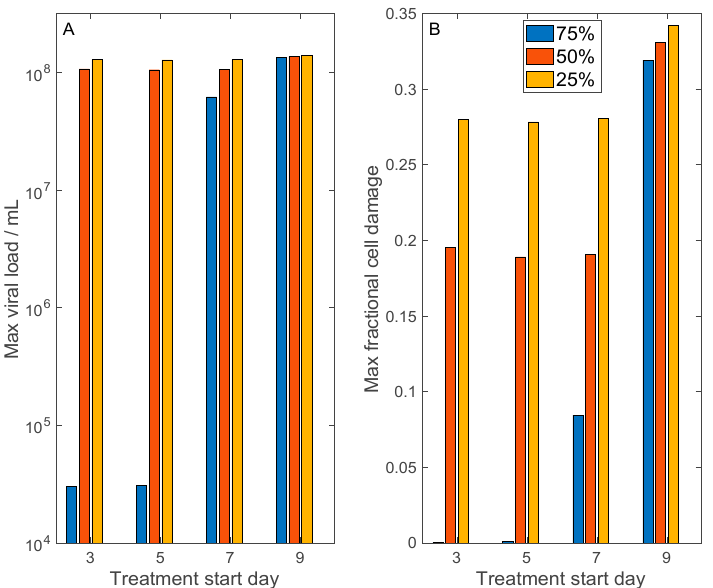
Figure 6. Model simulations to assess the results of antiviral therapies that inhibit cell entry by SARS-CoV-2. Considered are therapies that inhibit cell entry by 75%, 50%, and 25%. Treatment may begin 3, 5, 7, or 9 days after initial exposure to SARS-CoV-2. Panel ( A ), predicted maximum viral load. Panel ( B ), predicted maximum fractional cell damage. For the 75%-effective treatment, if applied within a week after exposure (or almost immediately after onset of symptoms), tissue damage may be limited to <10%. For the 50%-effective treatment, a similar timeline would limit tissue damage to ~20%. The 25%-effective treatment offers little